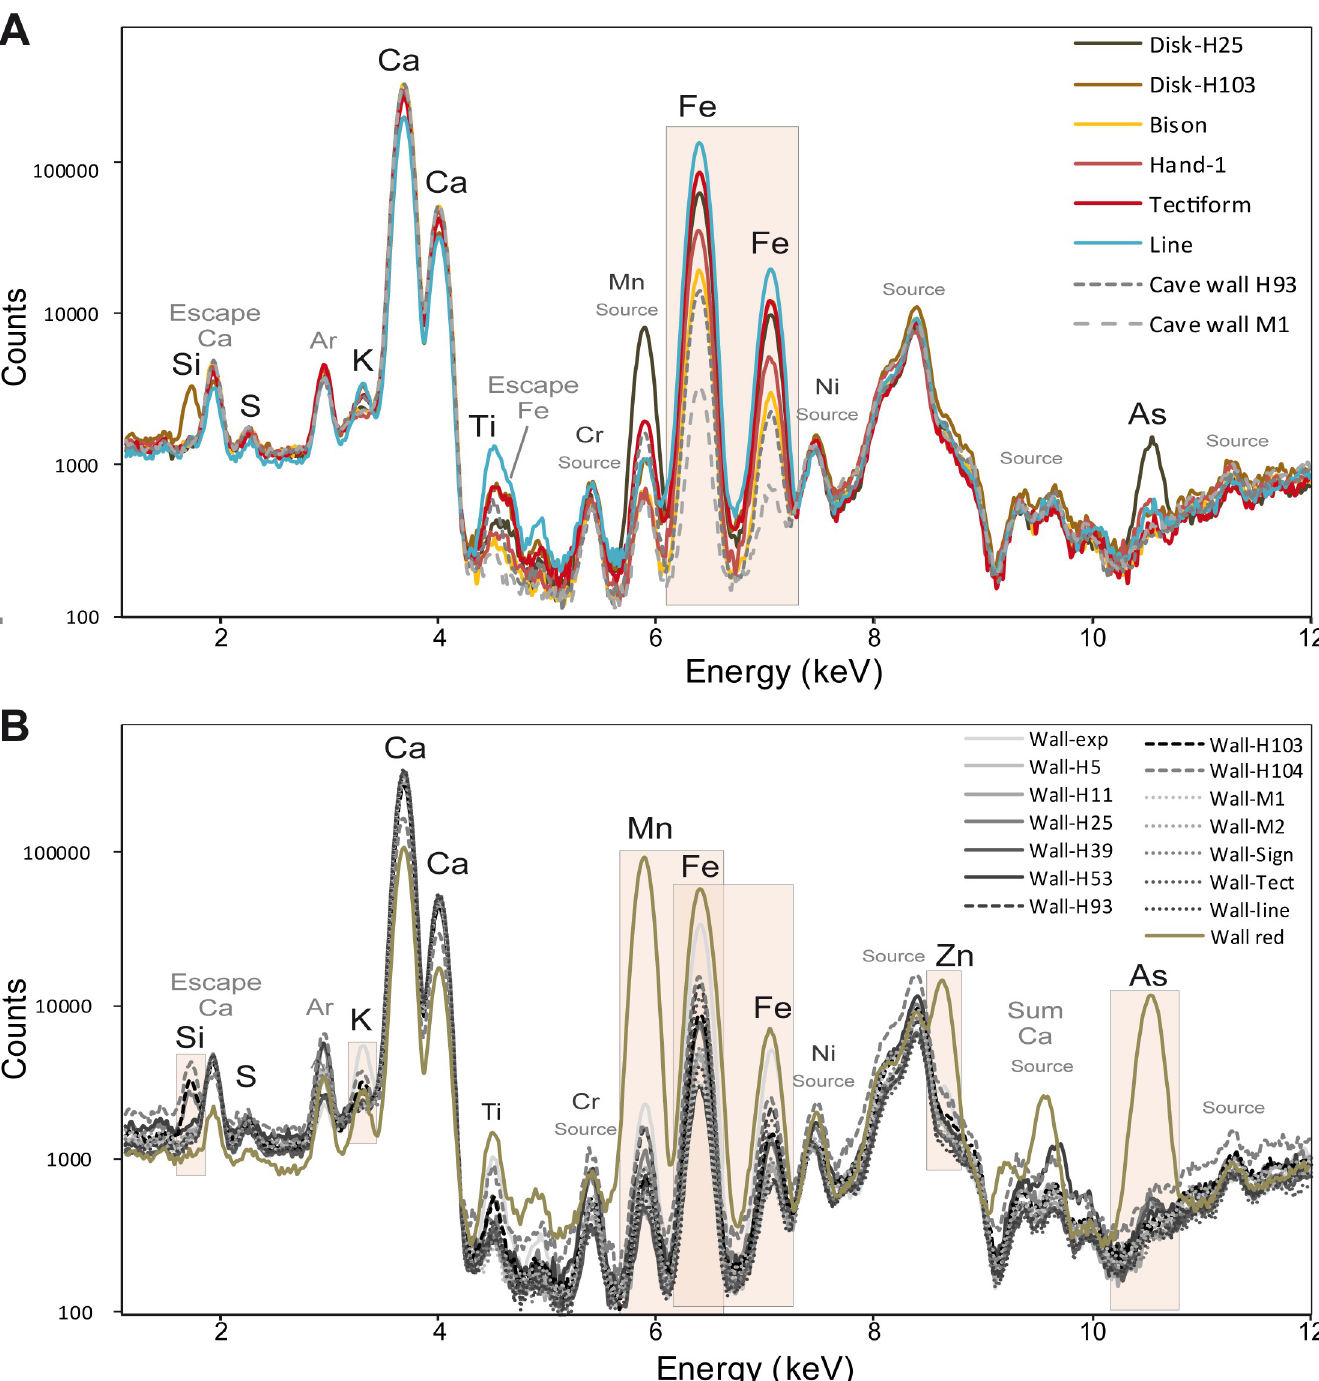
Fig 6. Normalised pXRF spectra of a selection of figures with the substrate (A) and normalised pXRF spectra of all the measurements carried out on the cave wall (B).